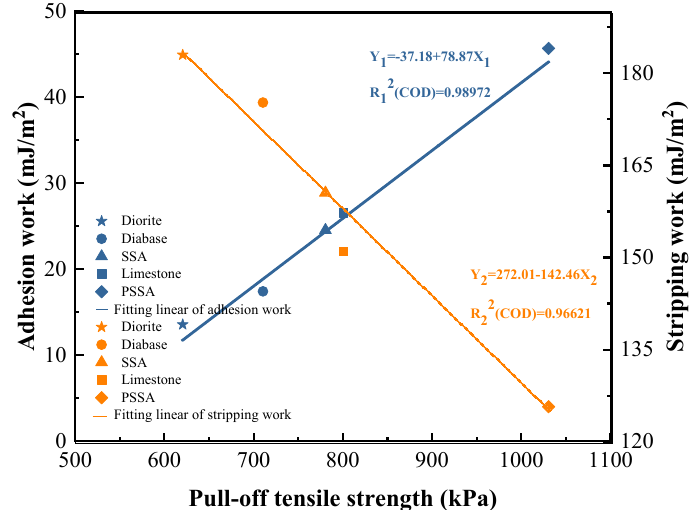
13 of 21 Figure 12. BBS test results. To correlate the results from BBS test and surface energy test, the adhesion work and stripping work of various aggregate types were fitted with the pull-off tensile strength,